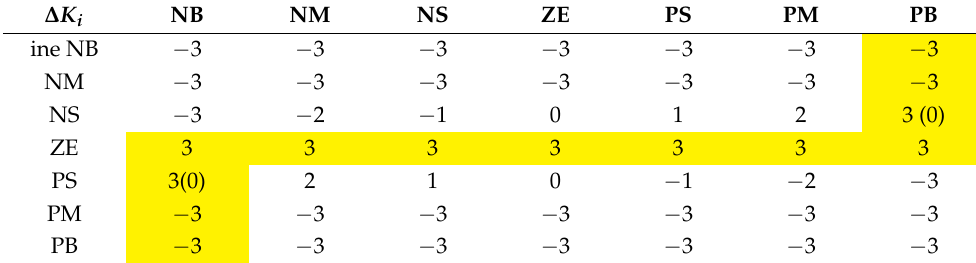
Table 3. Fuzzy rule base of ∆ K i (yellow background are the cells of sparse rule